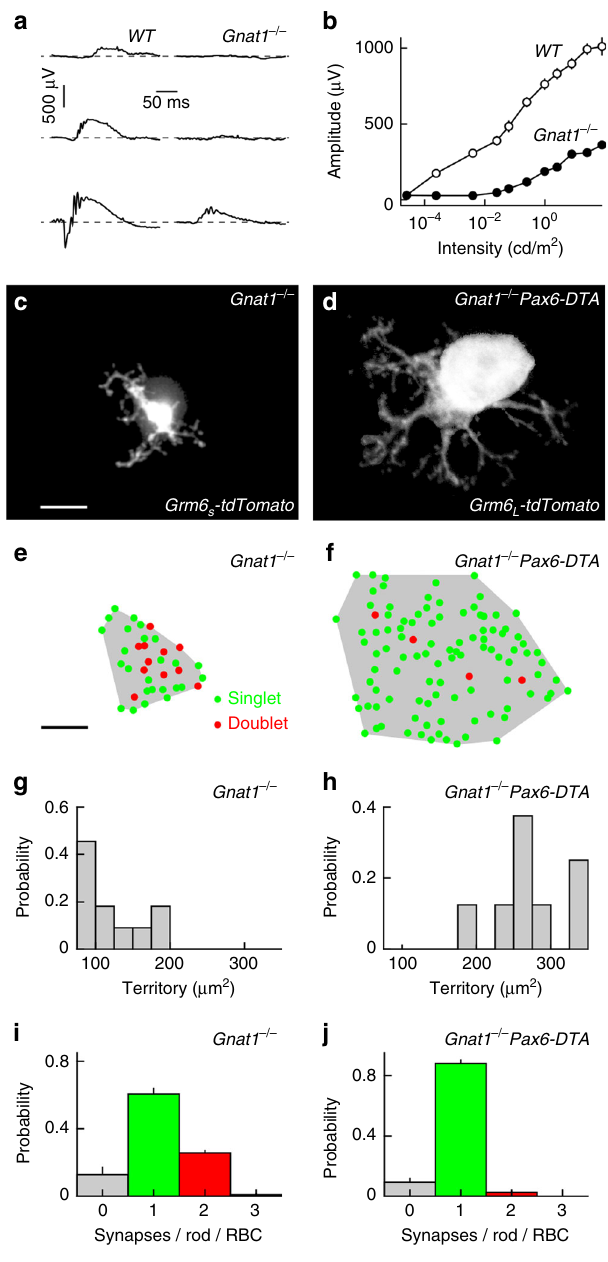
Fig. 5 RBC plasticity is independent of light-evoked rod input. a Representative ERG responses to stimuli of increasing light intensity (top row: 0.00025 cd/m 2 , middle row: 0.25 cd/m 2 , bottom row: 25 cd/m 2 ) recorded from wild-type (left column) and Gnat1 − / − (right column) retinas. b Summary data of intensity response functions measured from b-wave amplitudes in wild-type (open circles, n = 6 mice) and Gnat1 − / − ( fi lled circles, n = 4 mice) animals. c , d MIP of dendritic trees of individual RBCs labeled via AAVs ( Grm6 S -tdTomato ) or in a transgenic line ( Grm6 L - tdTomato ) in Gnat1 − / − ( c ) and Gnat1 − / − Pax6-DTA ( d ) mice. For visual clarity, RBCs were digitally isolated in Amira. Scale bar indicates 5 μ m. e , f Maps of dendritic territories (gray shaded areas) and synapse con fi gurations (singlets: green circles, doublets: red circles) of the cells shown in c and d . Scale bar indicates 5 μ m. g , h Summary data of RBC dendritic territories in Gnat1 − / − ( g , n = 13 RBCs, n = 5 mice) and Gnat1 − / − Pax6-DTA ( i , n = 8 RBCs, n = 4 mice, p < 0.001) mice. i , j Population data (mean ± SEM) of the distribution of synapses con fi gurations on RBC dendrites in Gnat1 − / − ( i , n = 11 RBCs) and Gnat1 − / − Pax6-DTA ( j , n = 8 RBCs, n = 4 mice, p < 0.04)